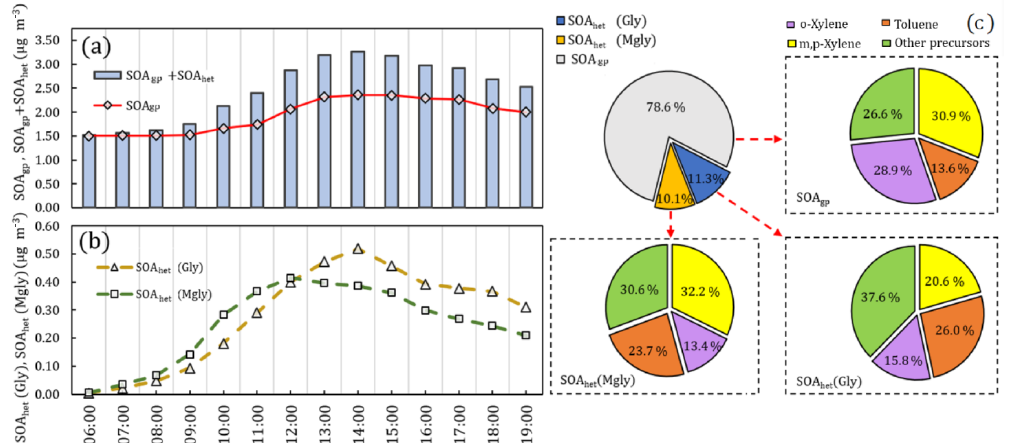
Figure 4. The average diurnal variations in SOA gp , SOA het (Gly) (i.e., SOA het formed from heterogeneous processes of Gly), SOA het (Mgly) (i.e., SOA het formed heterogeneous processes from Mgly) and total SOA formation (SOA gp + SOA het ) are shown in (a) and (b) (local time). The proportion of SOA gp , SOA het (Gly) and SOA het (Mgly) in total SOA, as well as the contribution of VOC precursors to SOA gp , SOA het (Gly) and SOA het (Mgly) formation, is represented in the pie charts in (c) . Table 3. Surface uptake coefficient of Gly from laboratory experiments and used in the model simulation in the present and previous studies.